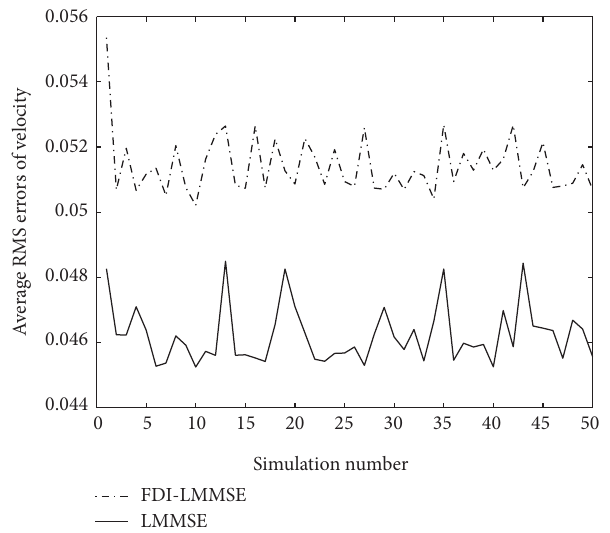
Figure 5: Comparison between state estimators of 𝑥(1) under no faulty case and faulty case, respectively, and real state